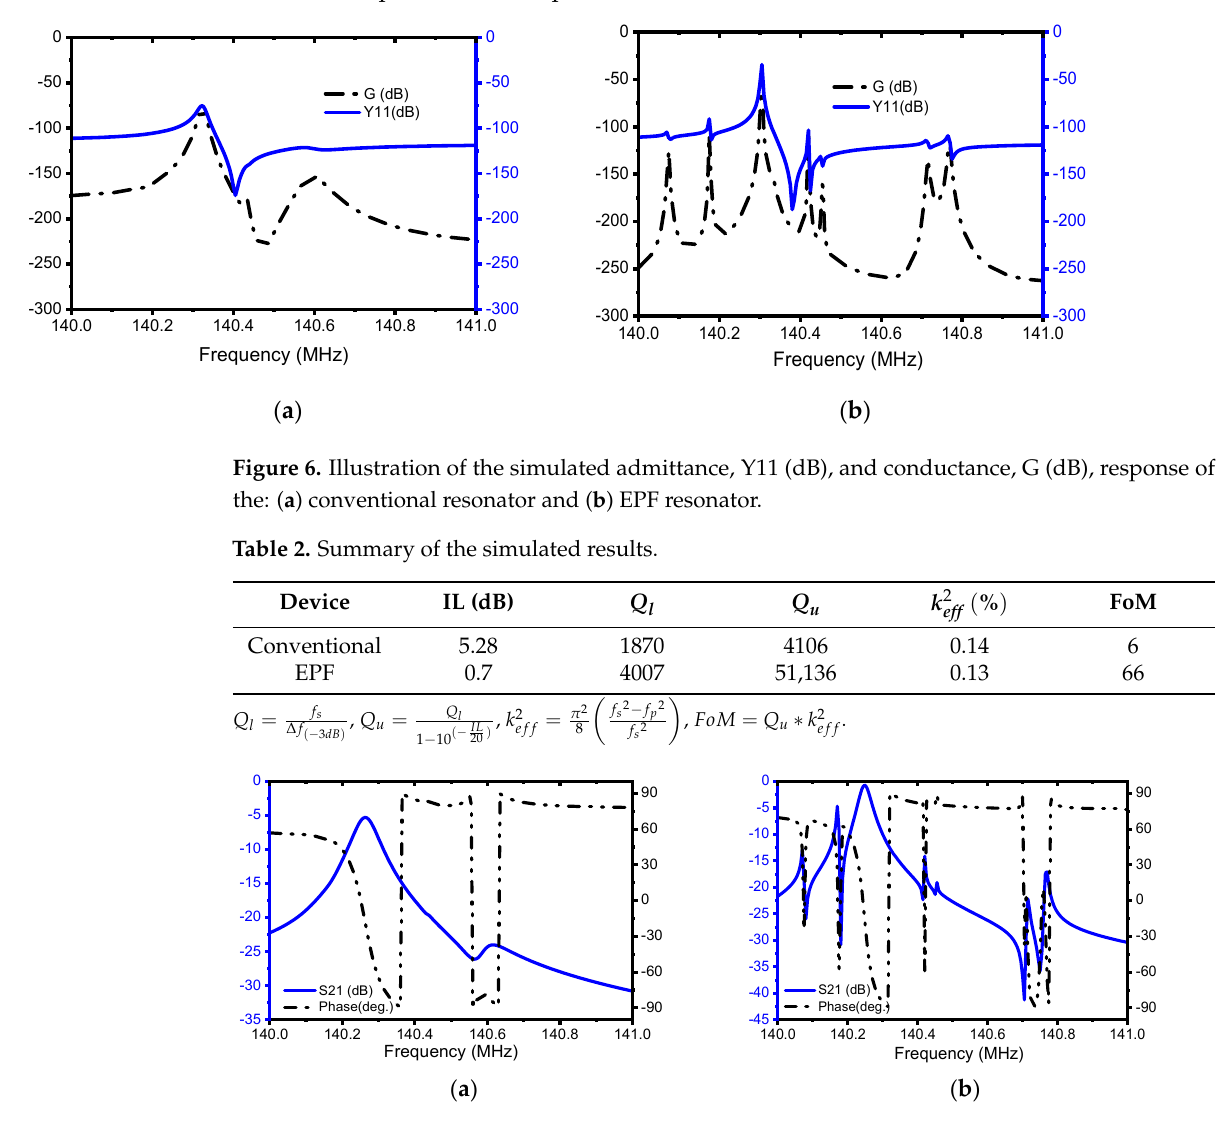
Figure 7. Illustration of the simulated S-parameter, S21 (dB) and phase (deg.) response of ( a ) the conventional resonator and ( b ) EPF resonator.